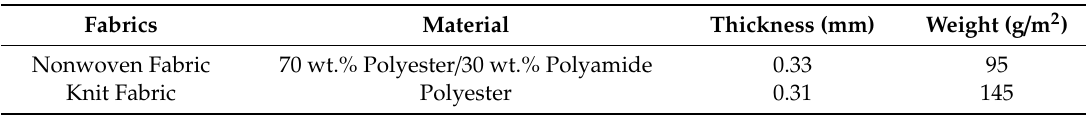
Table 1. Specification of the fabric for antenna design.